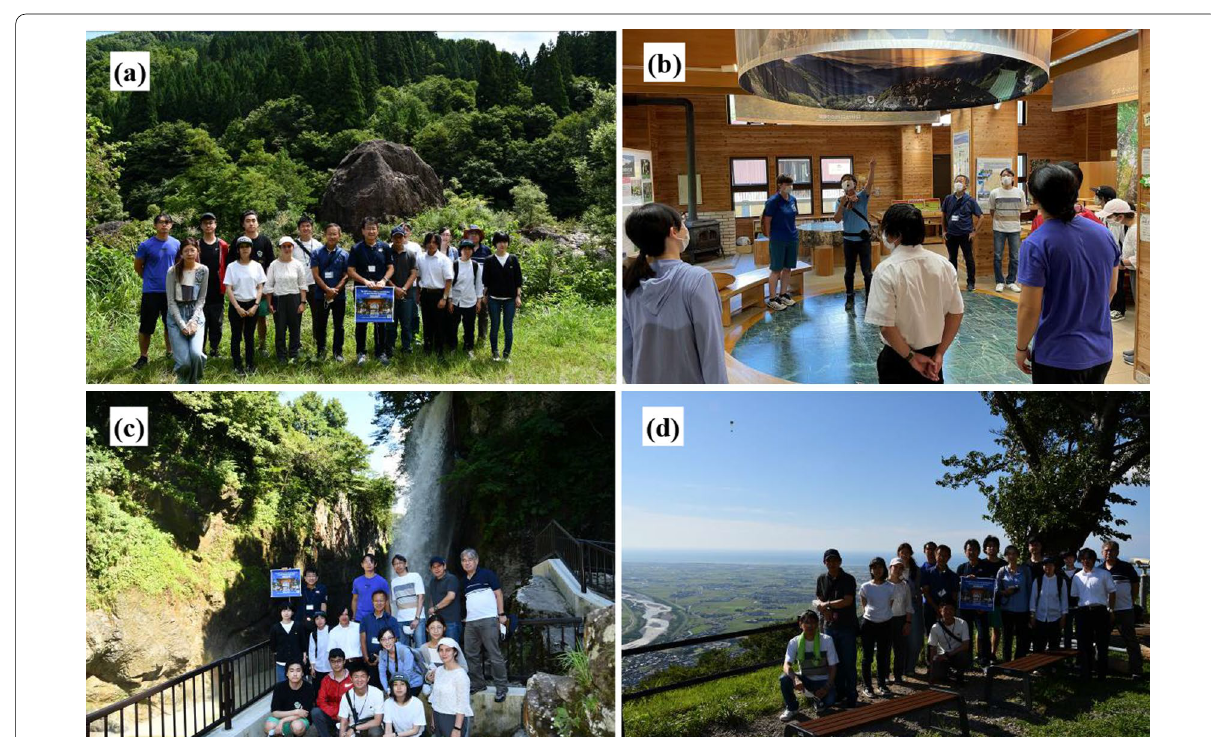
Fig. 8 Technical trip at Hakusan Tedorigawa Geopark: a Hyakumangan Rock; b Ichinose Visitor Center; c Watagaya waterfall on Tedori Canyon;